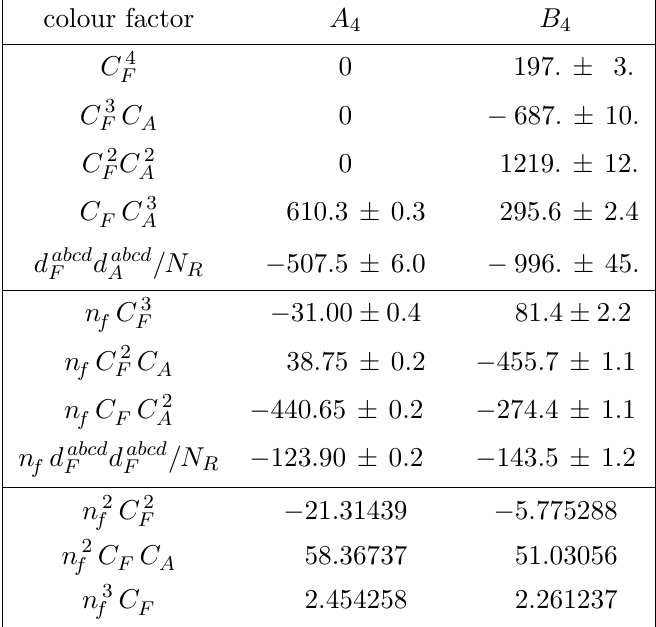
and n 1 parts. For completeness also the exactly known n 2 f f